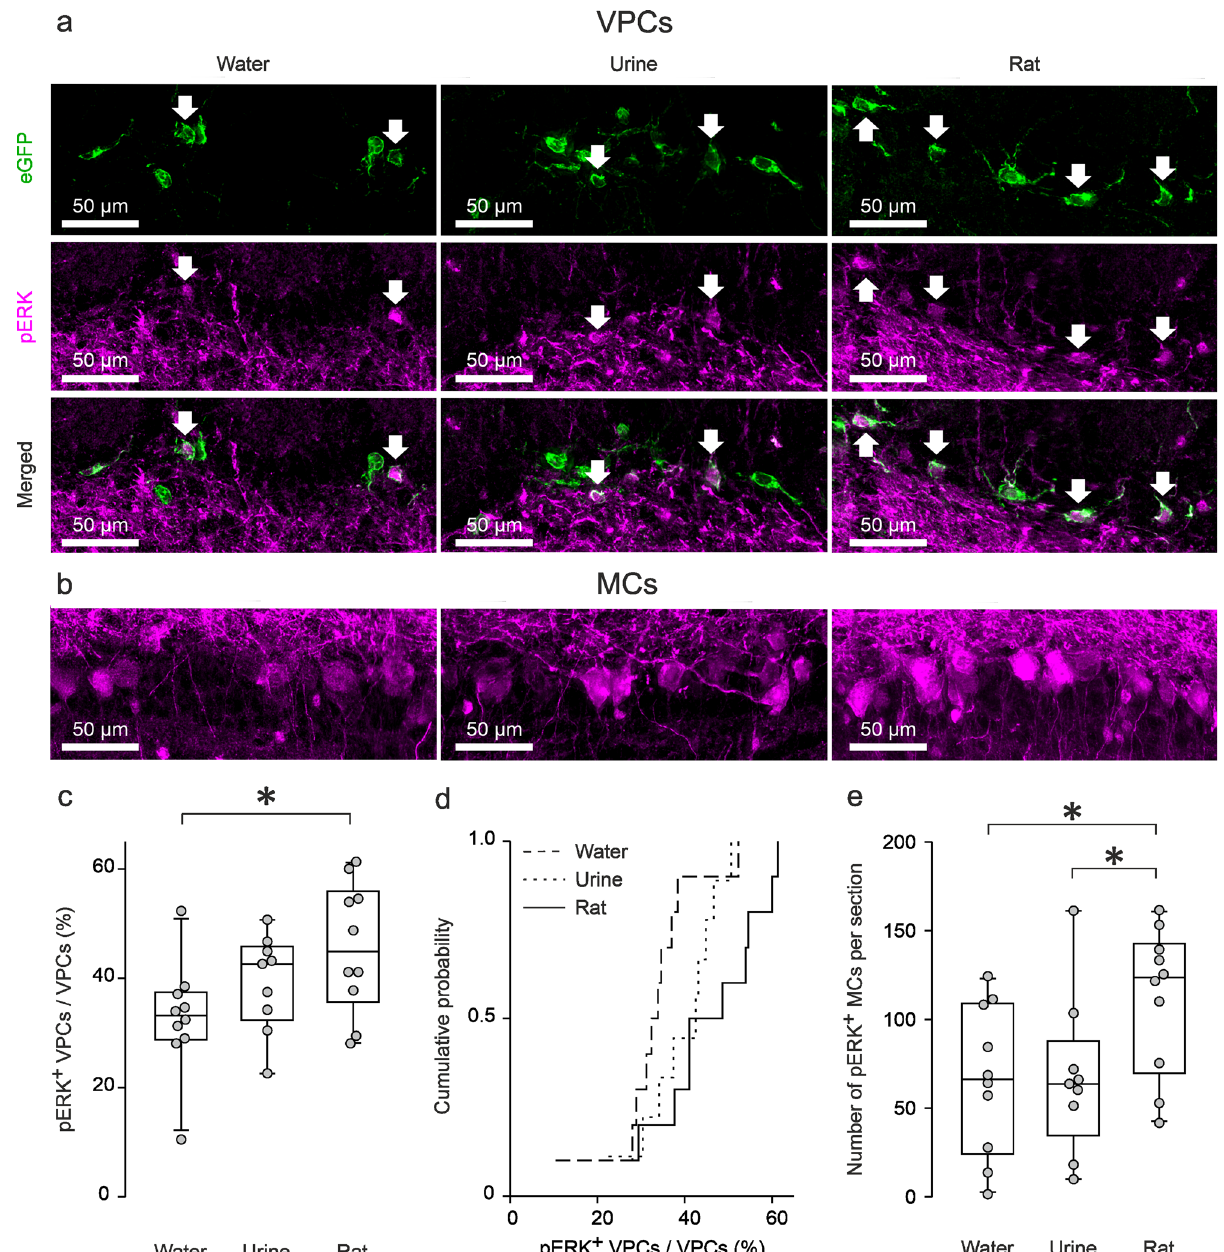
CF488) and pERK (magenta, CF 594). Scale bar, 50 µ m valid for all images in the same panel. a VPCs following water, urine, or rat stimulation. Arrows indicate cells that are double-labeled for eGFP and pERK. b pERK + MCs. c Averaged fraction of pERK + VPCs of all VPCs in different stimulation groups (%). One-way ANOVA, LSD for single comparison, * p < 0.05 rat vs. water. d Cumulative probability of averaged fraction pERK + VPCs of all VPCs in different stimulation groups (%). e Averaged number of pERK + MCs per section in different stimulation groups. One-way ANOVA, LSD for single comparison, * p < 0.05 rat vs. water and rat vs. urine. Data are presented as box-plots including fi rst, median, and third quartiles with whiskers representing the range of data points and distribution of single data points. n = 10 rats (water), n = 9 rats (urine), n = 10 rats